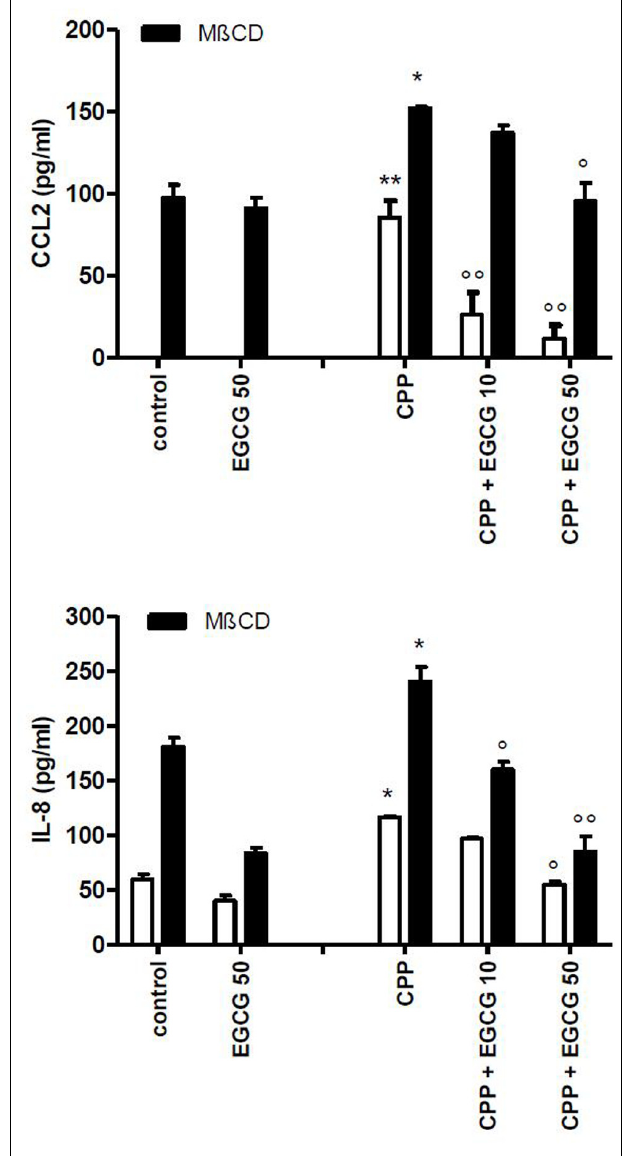
FIGURE 5 | Effect of EGCG on IL-8 and CCL2 production byTHP-1 stimulated with CPP crystals after a pretreatment of 45 min with M β CD. The values are expressed as the mean ± SD; CPP 0.025 mg/ml; M β CD expressed as millimolar; EGCG expressed as micromolar. Data are representative of one of three independent experiments ± SD of three replicates. * p < 0.05, ** p < 0.01 vs control; ◦ p < 0.05, ◦◦ p < 0.01 vs